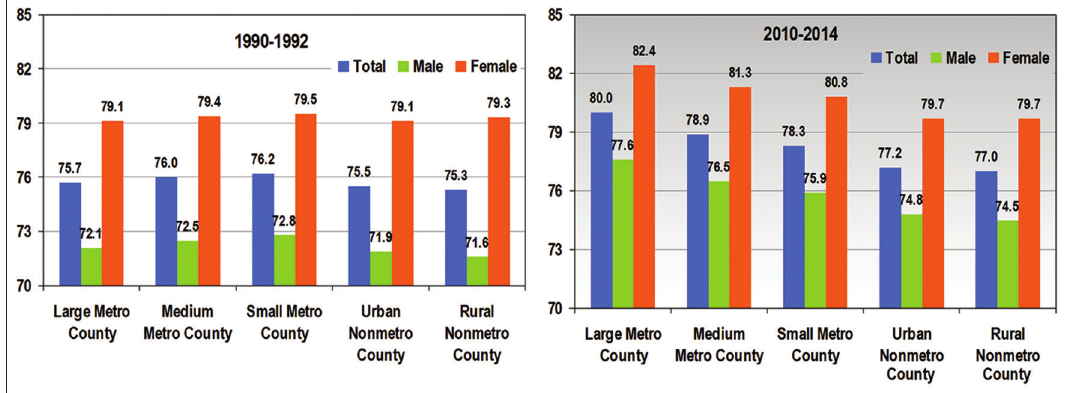
Fig ure 8. Life Expectancy at Birth (Years) by Levels of Urbanization, United States, 1990-1992 and 2010-2014 Source: Singh GK, Siahpush M. American Journal of Preventive Medicine. 2014; 46(2):e19-e29 (updated data). Data derived from the US National Vital Statistics System.